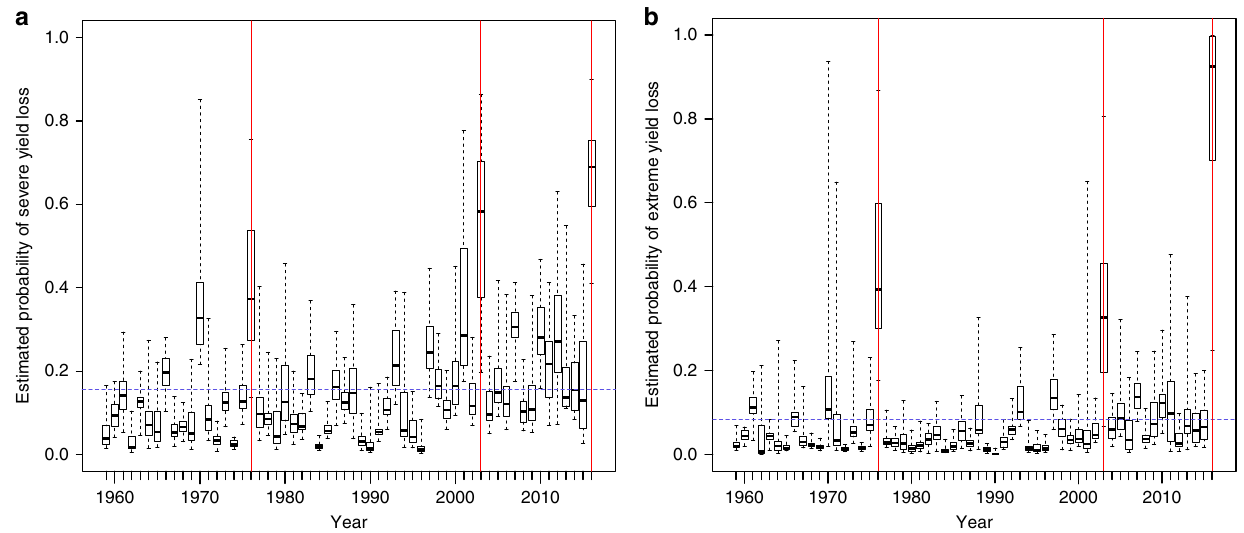
Fig. 3 Modeled probabilities. Estimated probabilities of a severe and b extreme yield loss (yields more than 10 and 15% lower than the expected value) from generalized linear regression models based on climate predictors fi tted to the full yield time series (1959 – 2016) in the breadbasket region. The dotted blue line is the prior probability (the empirical proportion of severe or extreme yield loss events in the dataset). As an indication, vertical red lines correspond to median yield loss occurrences across all departments larger than − 15% (i.e., in 1976, 2003, and 2016). Note that the fi gure for net yield losses is presented in the Supplementary Fig.